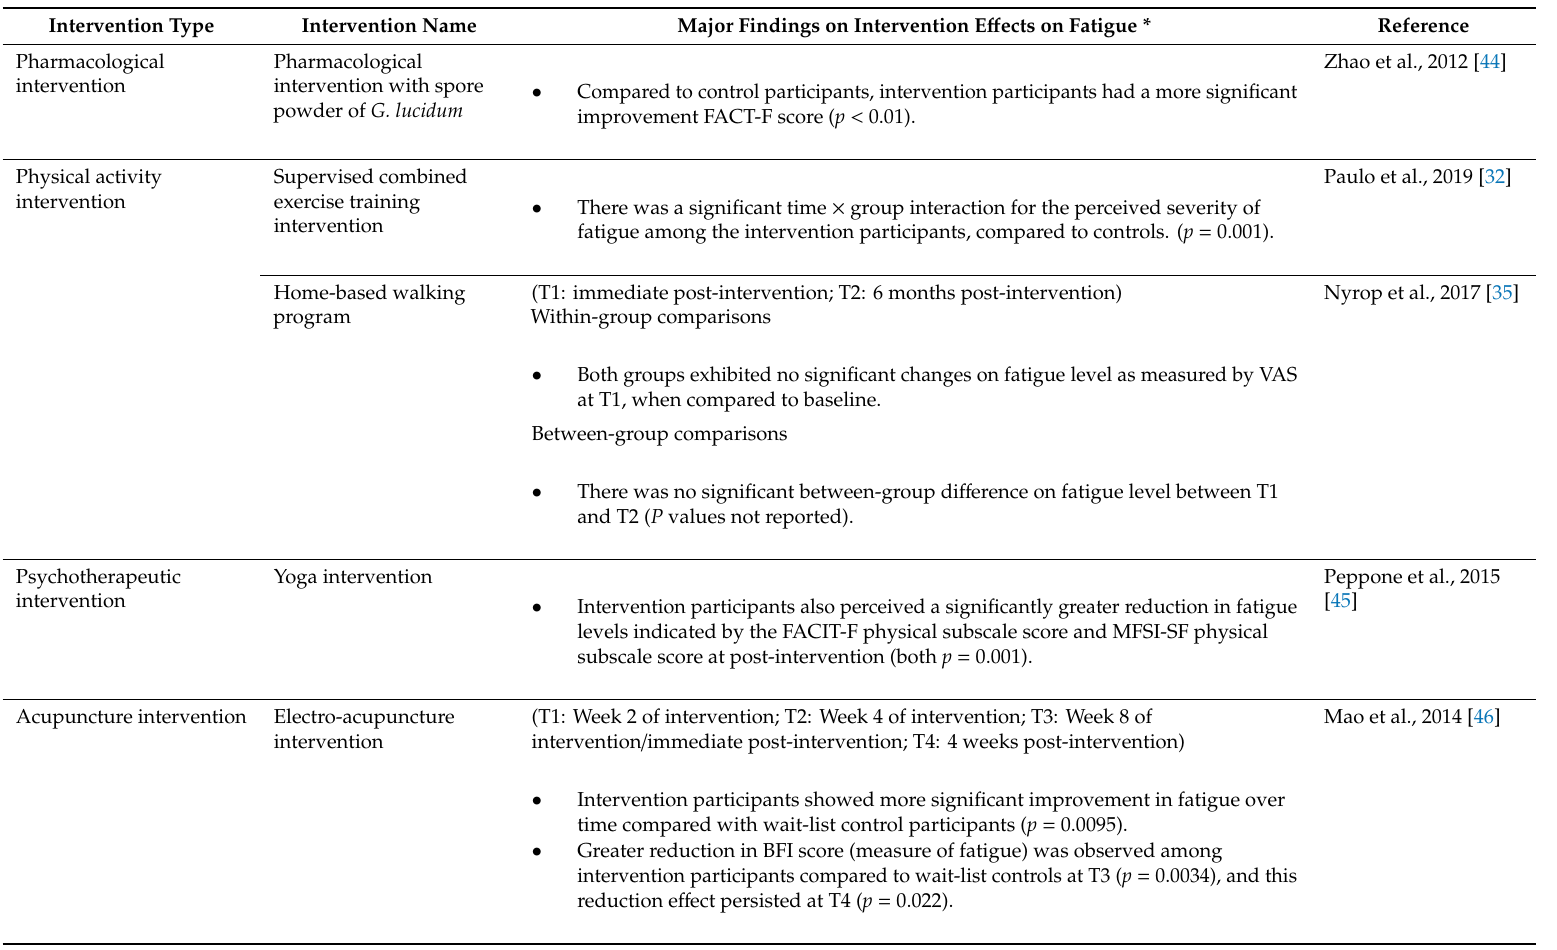
Table 6. A summary of the e ff ects of reported interventions on endocrine therapy-induced